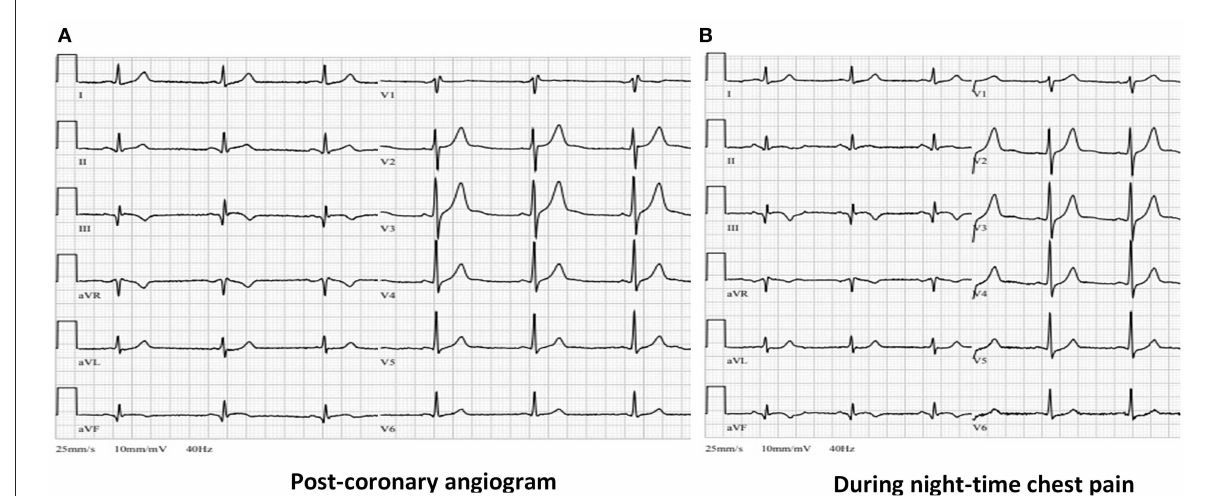
FIGURE5 (A) Post-procedural ECG from ICU showing resolution of ST-segment elevation in leads II, III and aVF with formation of negative “reperfusion” T waves in III and aVF leads. (B) ECG during the night chest pain episode showing no significant changes compared with (A) (ECG, electrocardiogram, ICU, intense care